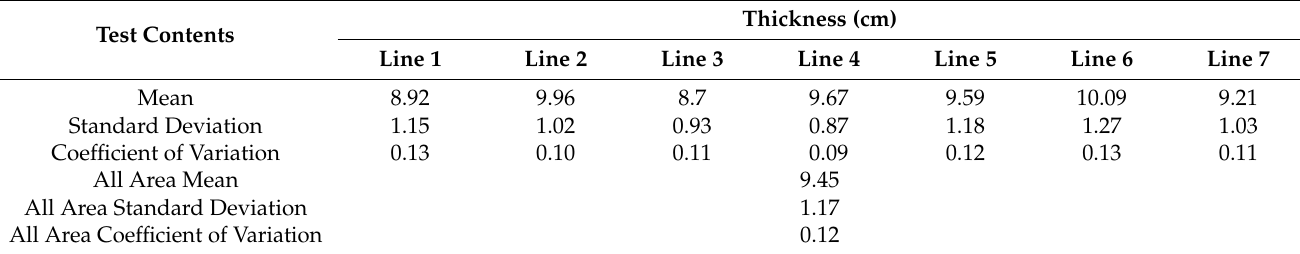
Table 5. Mean value of corrected thickness.